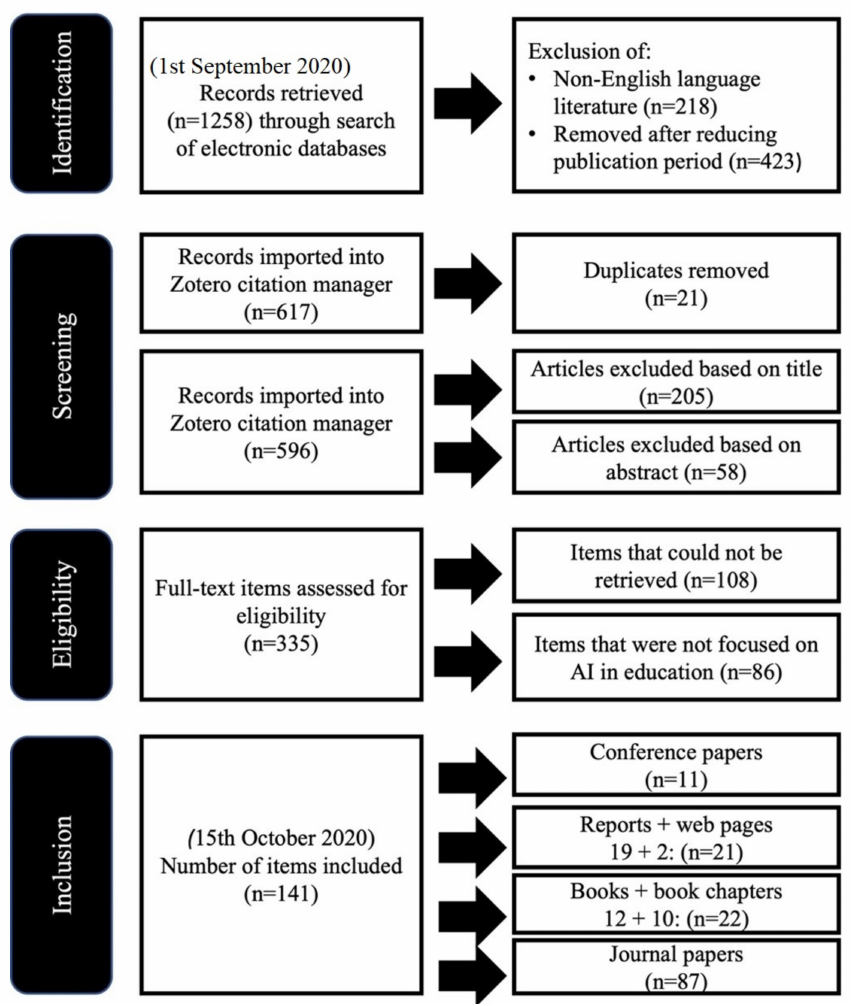
Figure 2. PRISMA diagram representing a sequential process for compiling the final